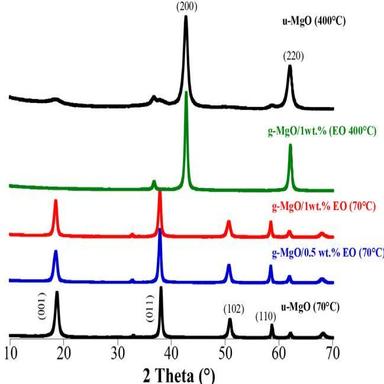
XRD traces of MgO nanoparticles grafted with essential oil at different concentrations.